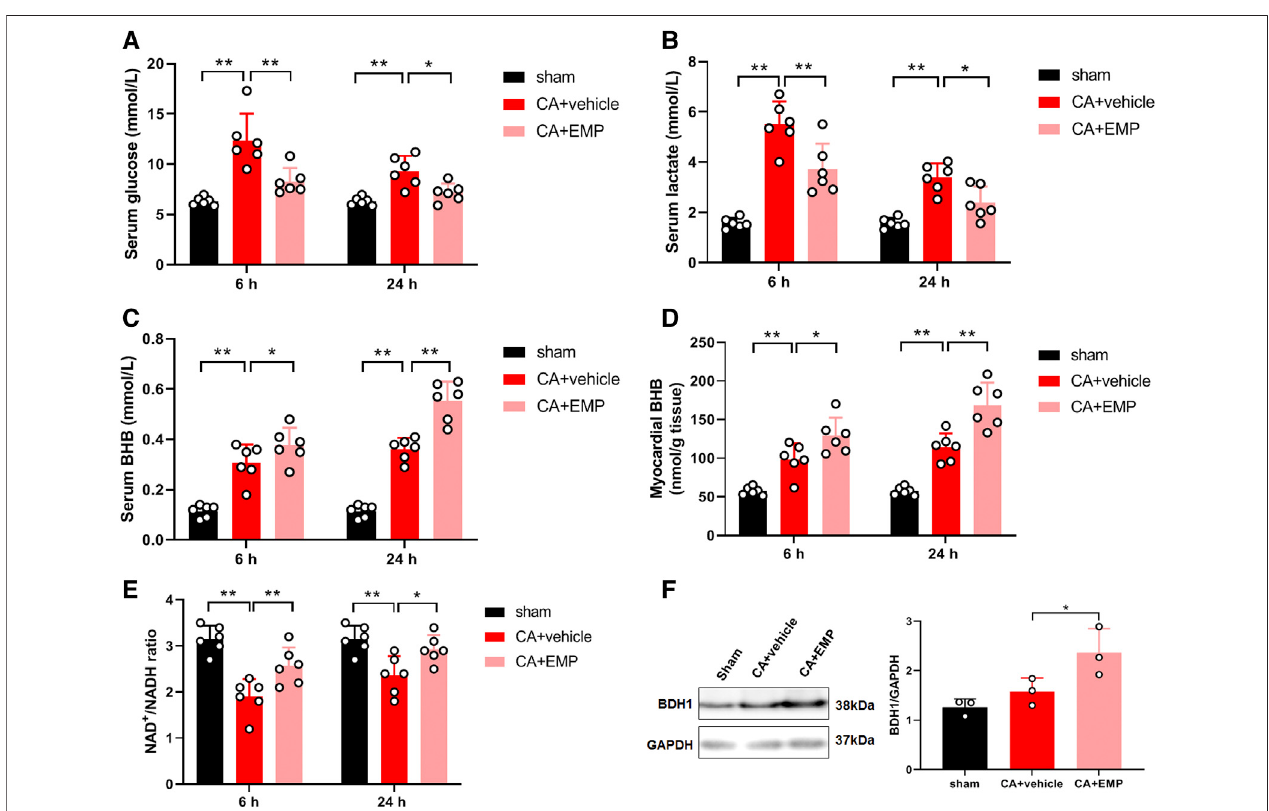
FIGURE 7 | Empagli fl ozin (EMP) increased myocardial ketone metabolism after cardiac arrest in rats. (A) EMP decreased serum glucose levels at 6 and 24 h after return of spontaneous circulation (ROSC). (B) EMP decreased serum lactate levels at 6 and 24 h after ROSC. (C) EMP increased the serum β -hydroxybutyrate (BHB) levelsat6and24 hafterROSC. (D) EMPincreasedthemyocardialBHBlevelsat 6and 24 hafter ROSC. (E) EMPincreasedthemyocardialNAD + /NADH levelsat 6and 24 hafter ROSC. (F) EMP increased theheart β -hydroxybutyratedehydrogenase (BDH1)protein expression at 24 h after ROSC. GAPDH wasused astheloading control. Data are presented as mean ± SD, n (cid:1) 3 or 6, * p < 0.05, ** p < 0.01.